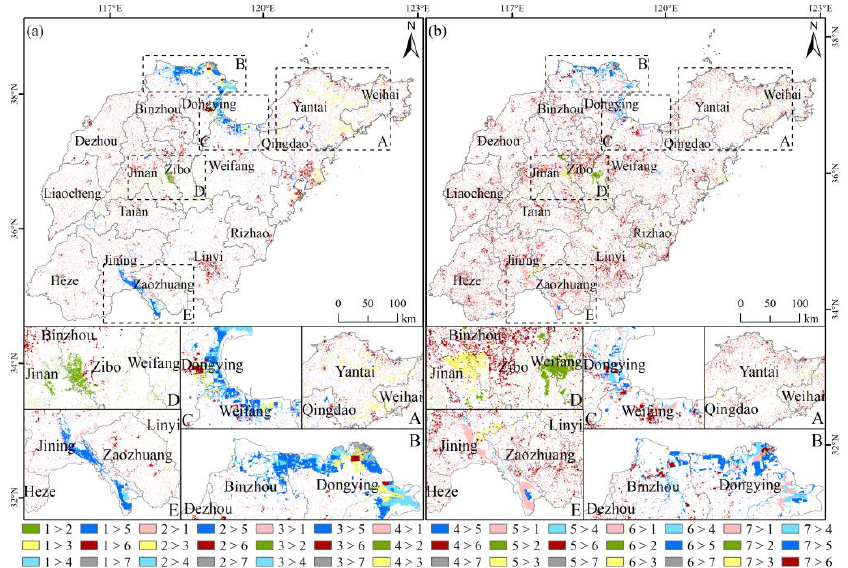
Figure 4. Spatial divergence of land use transfer. The values 1, 2, 3, 4, 5, 6, and 7 represent cropland, woodland, grassland, wetland, water, construction land, and unused land, respectively. ‘>’ indicates the transition process. ( a ) From 2000 to 2010; ( b ) from 2010 to 2019. A, B, C, D, E refers to areas with